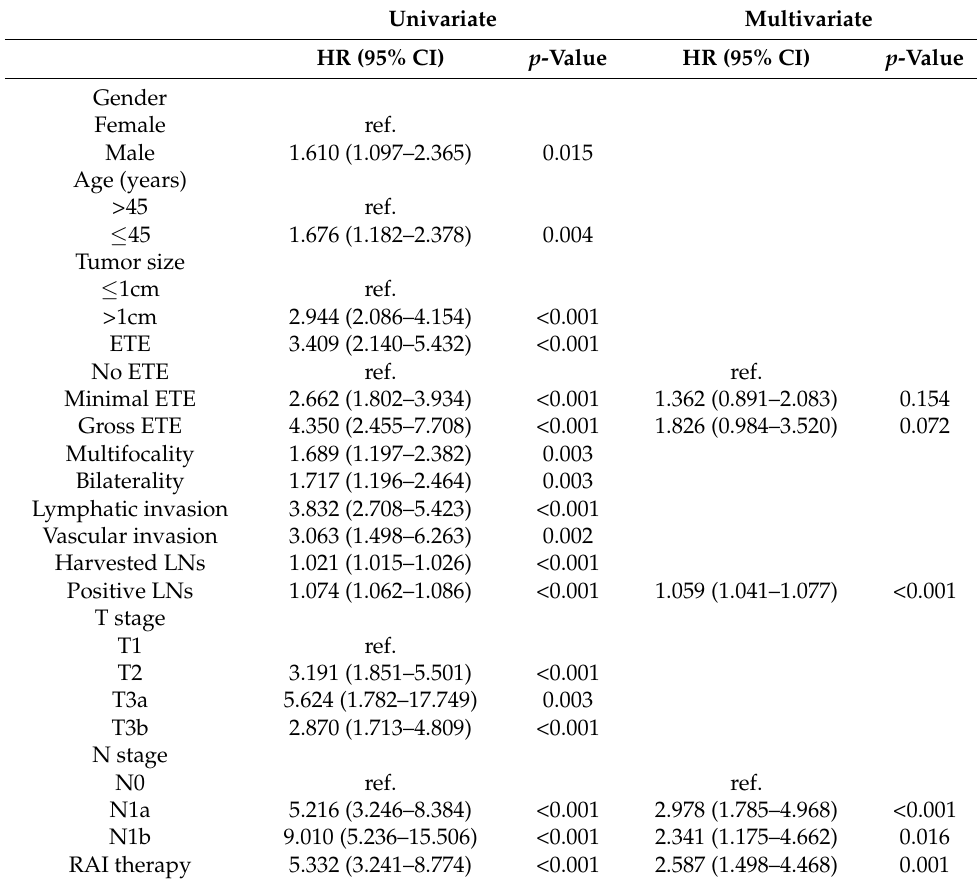
Table 2. Univariate and multivariate analyses of risk factors for recurrence before propensity score